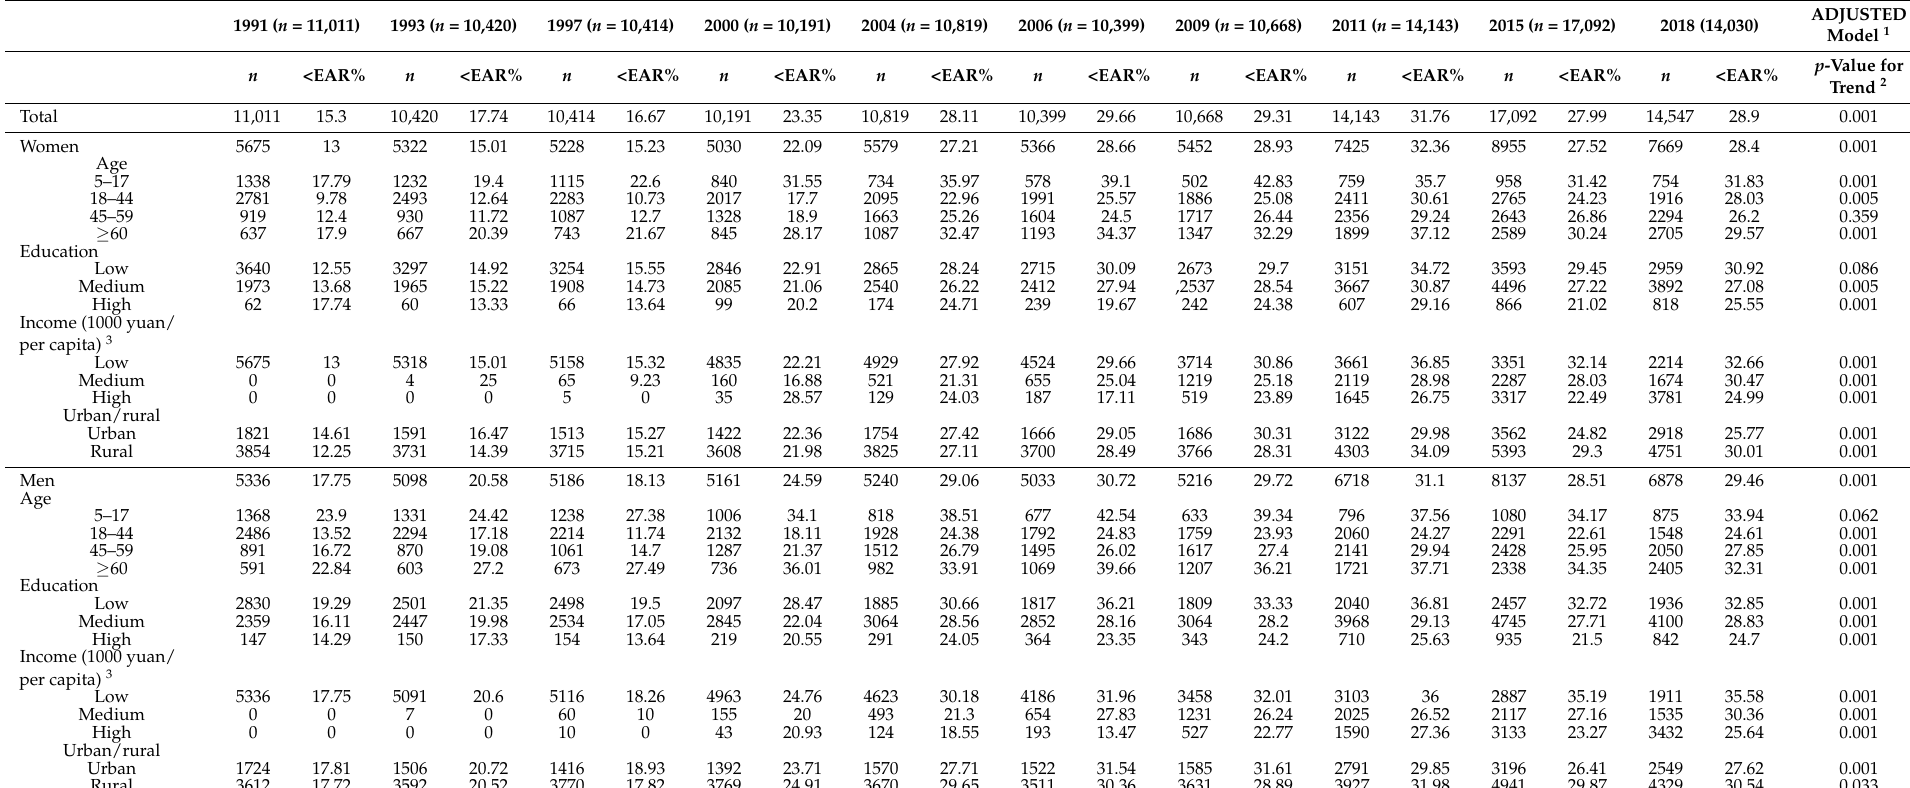
Table 2. Trends in dietary intake of niacin among residents aged ≥ 5 years, the China Health and Nutrition Survey (CHNS)